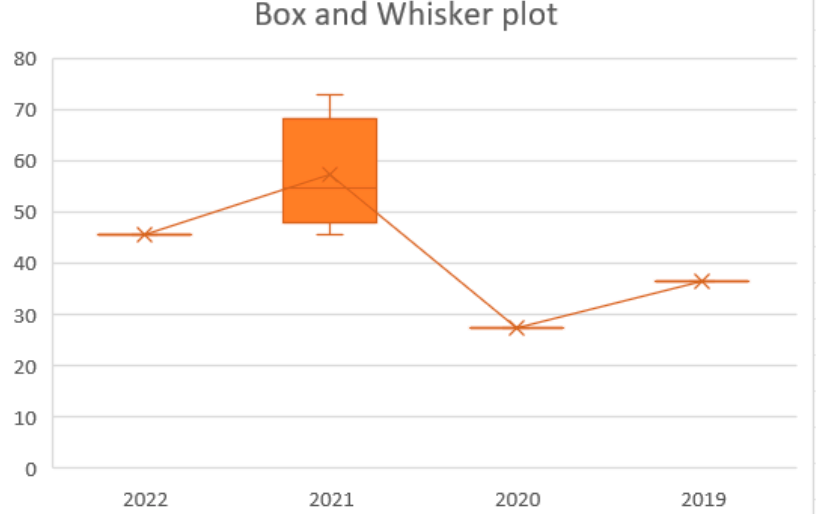
Figure 2. Variation of the OConfidence throughout the years for the PRISMA-driven reviews .